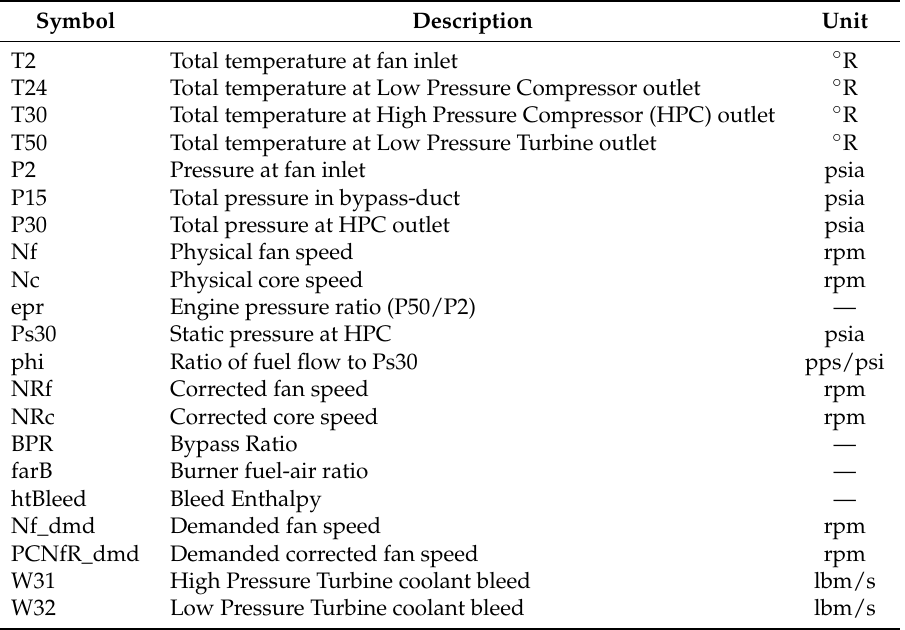
Table 1. Description of the commercial modular aero-propulsion system simulation (CMAPSS) dataset sensor